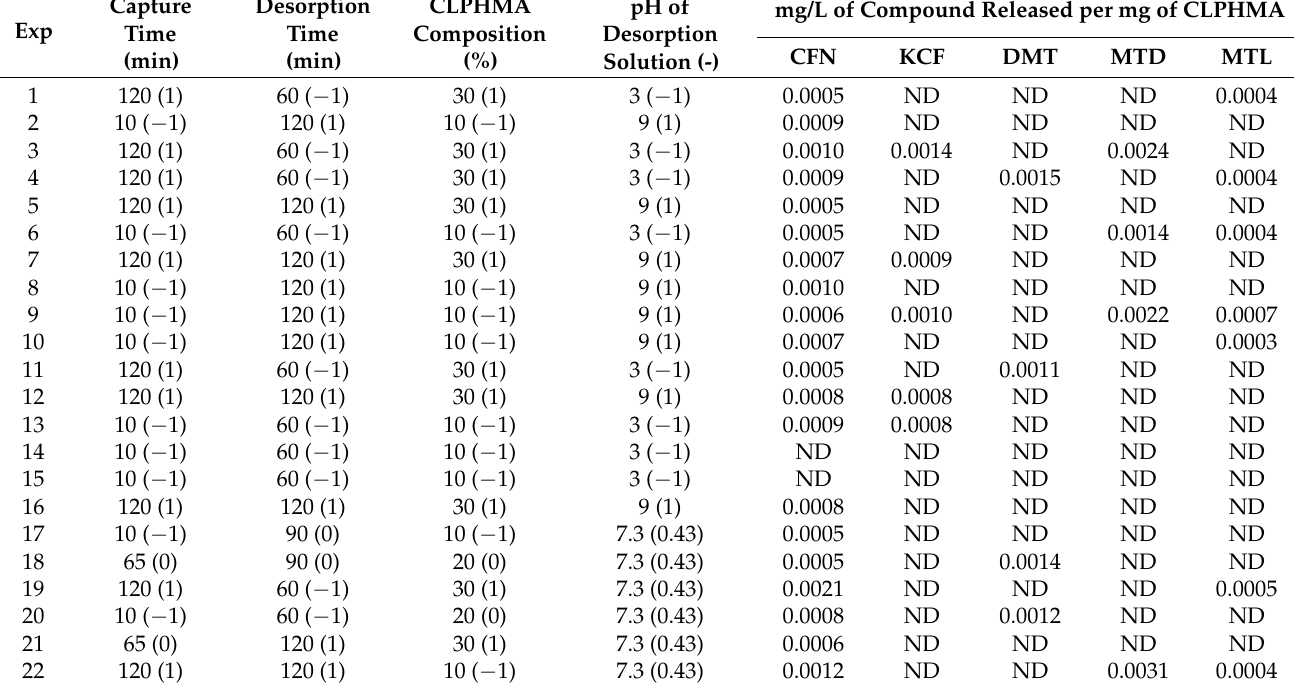
Table 3. Assay to describe and optimize the capture and desorption of selected compounds by CLPHMA with mechanical agitation. Numbers in parentheses correspond to the coded values of the variables under study (ND: Not